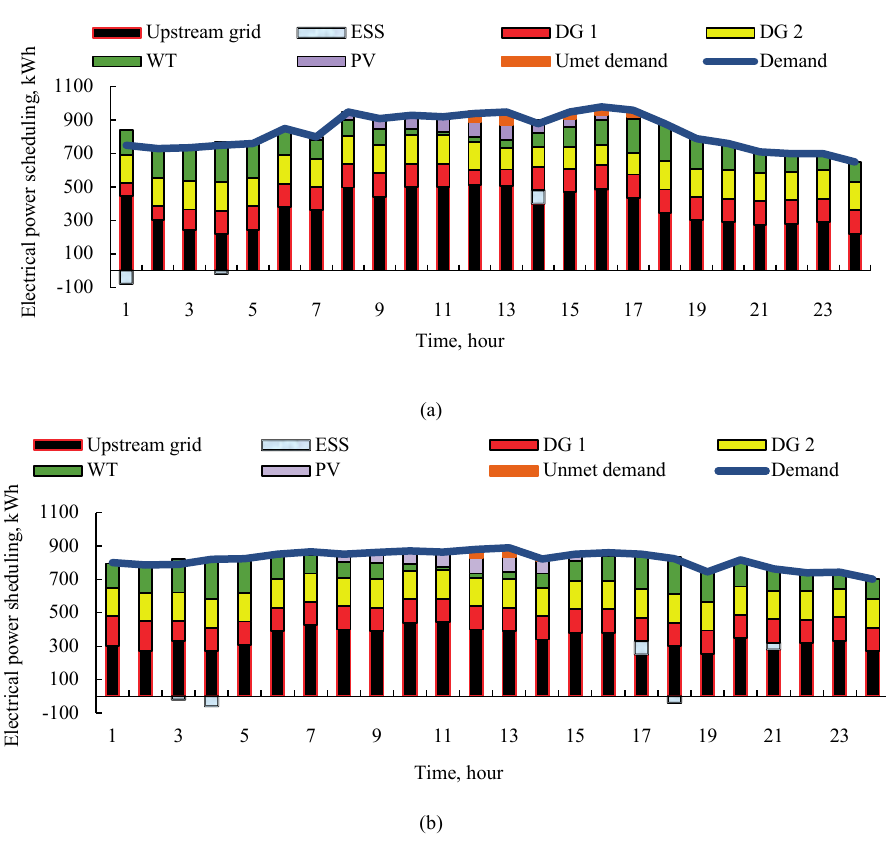
Fig. 7. Electrical power scheduling. a) Case A and b) Case